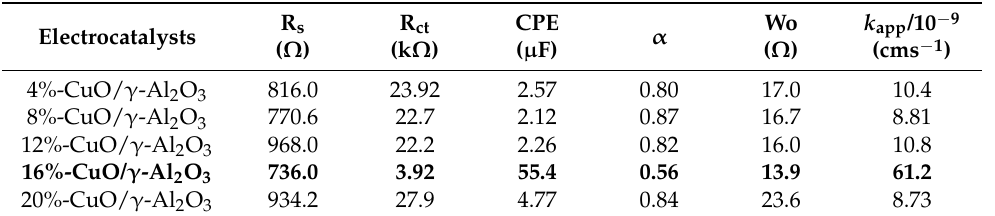
Table 2. Parameters estimated from EIS analysis of electrocatalysts.